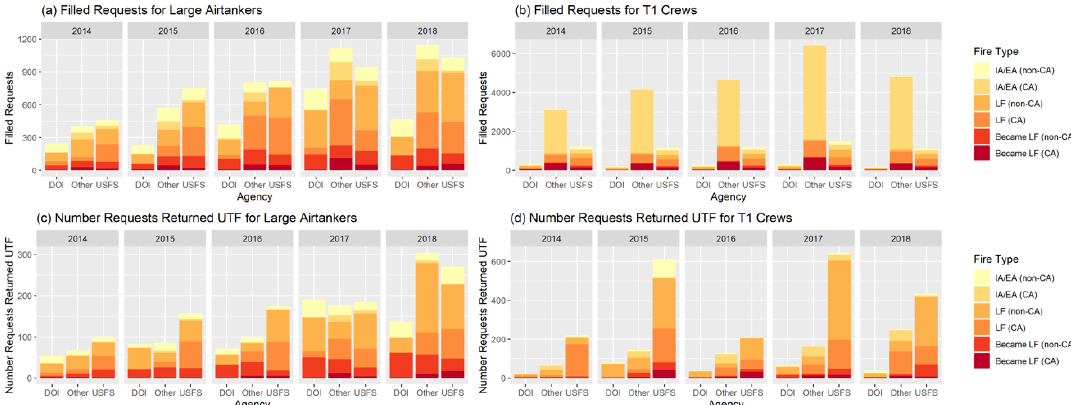
Figure 7. The number of filled requests for large airtankers ( a ), number of filled requests for Type 1 crews ( b ), number of requests returned UTF for large airtankers ( c ), and number of requests returned UTF for Type 1 crews ( d ) by year (2014–2018), bars colored by the type of fire and the fire location, i.e., inside or outside of California (CA) and Alaska (AK), requesting the resource.